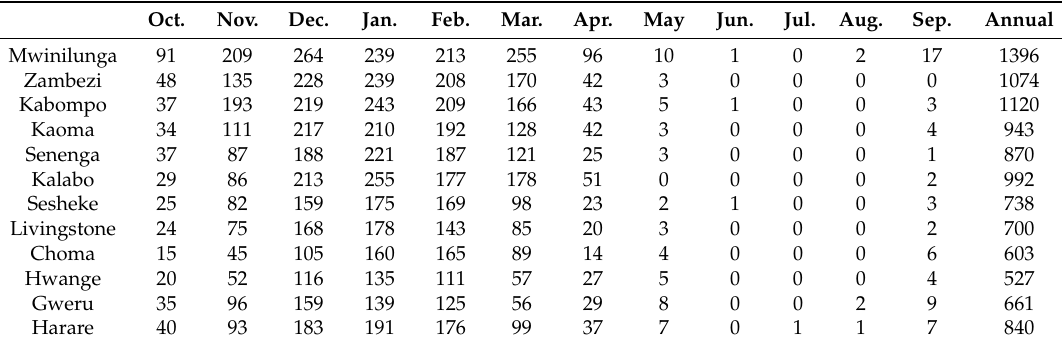
Figure 2. Climate and Hydrology in the Zambezi River Basin. The ( top ) is the mean monthly Rainfall and potential evaporation. The ( bottom ) plot is mean monthly runoff at Lukulu before the Barotse plains and Senanga after the Barotse plains, both are upstream of Victoria Falls. Table 1. Mean monthly and annual rainfall (mm) for some selected stations in Zambezi River Basin. For location of individual stations, see Figure 1.